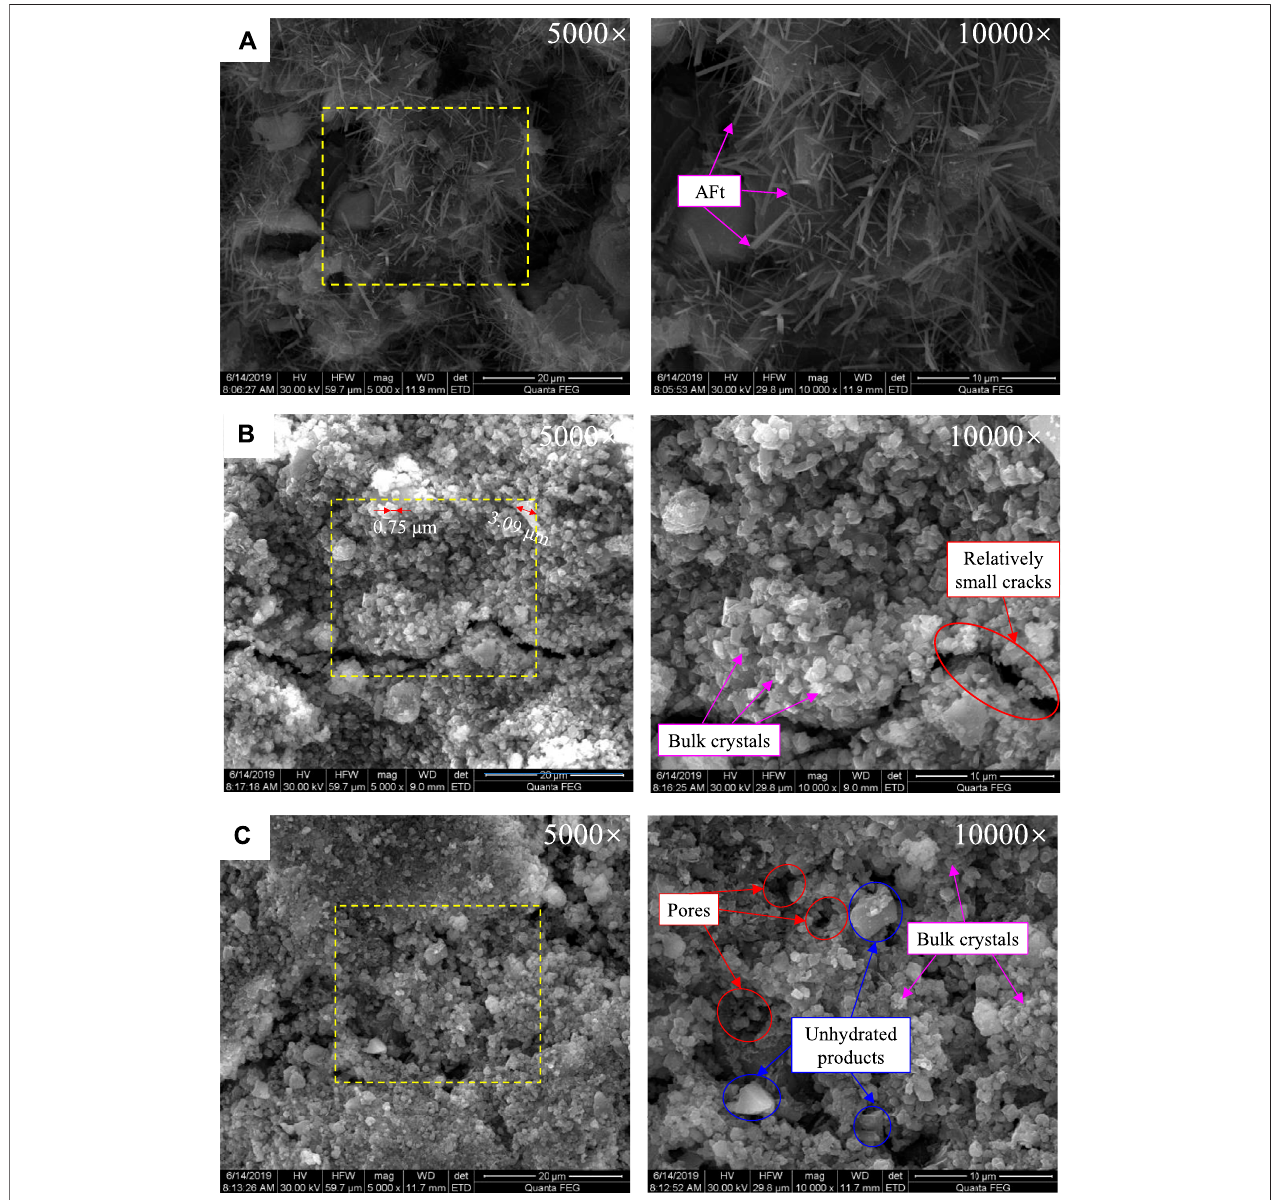
FIGURE4| SEMresults:saturatedconcretecontainingnanomaterials, (A) samplecontainingnano-SiO 2 ; (B) samplecontainingnano-Al 2 O 3 ; (C) samplecontaining nano-TiO 2